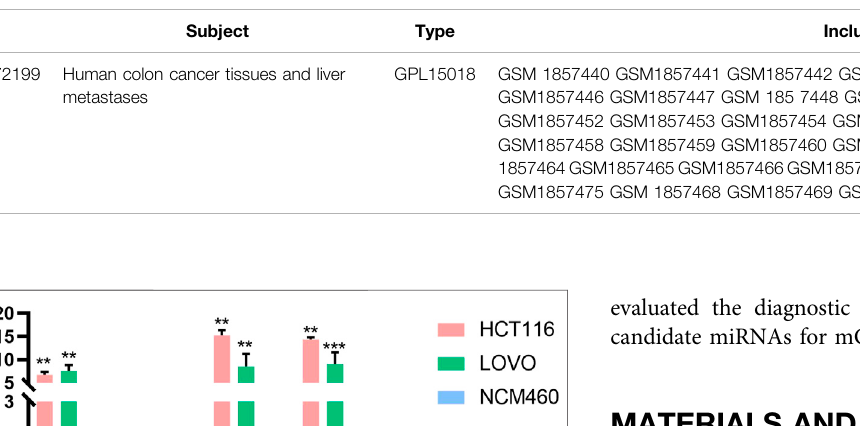
TABLE 1 | Chip set of metastatic colorectal cancer.